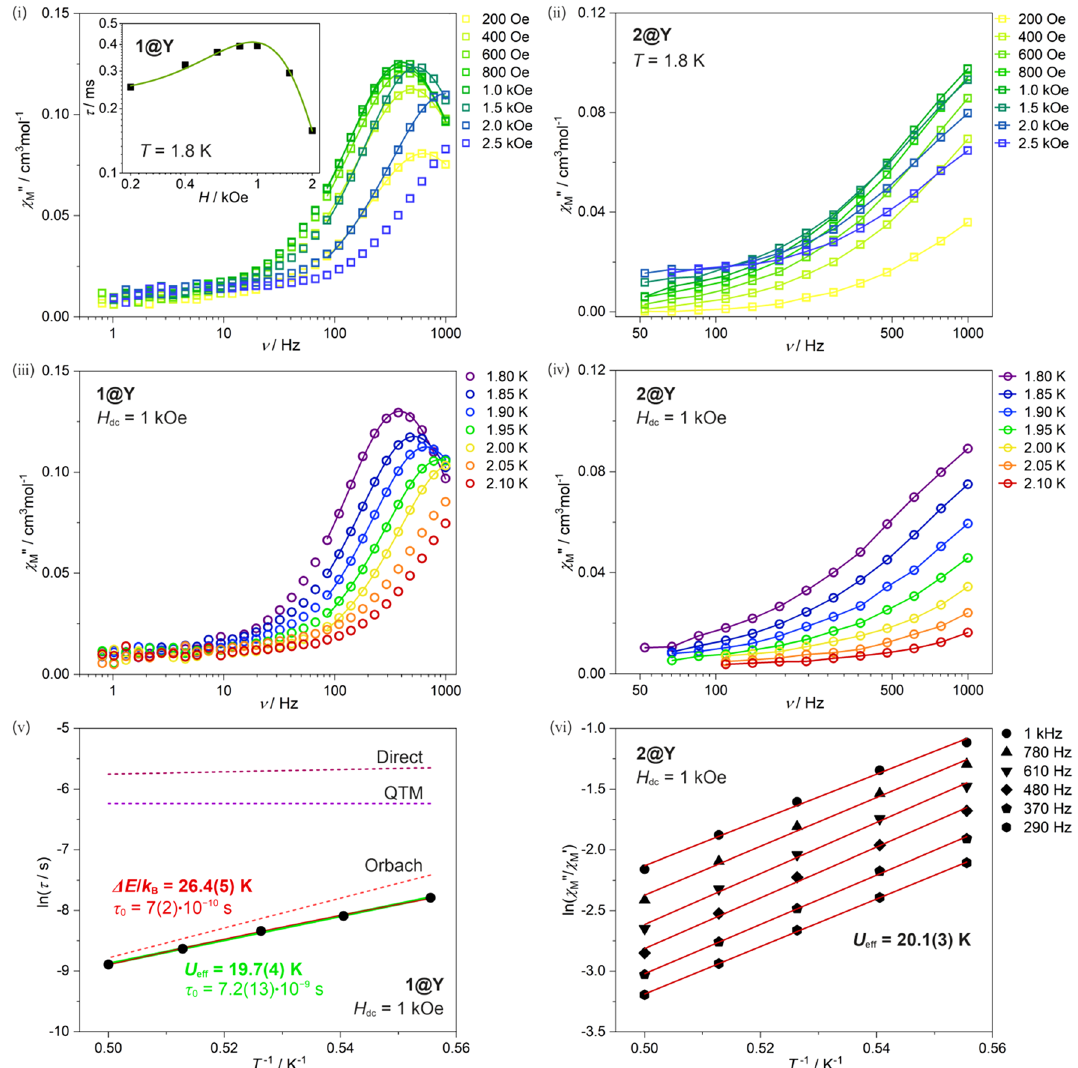
Figure 2. Dynamic ( ac ) magnetic properties of 1@Y (left) and 2@Y (right): dc -field-variable frequency dependences of the out-of-phase susceptibility, χ M ” of 1@Y (i) and 2@Y (ii) gathered in the 200–2500 Oe range at 1.8 K, and the related field dependence of the relaxation time for 1@Y (i), temperature-variable frequency dependences of the χ M ” of 1@Y (iii) and 2@Y (iv) collected in the 1.8–2.1 K range at H dc = 1 kOe, the related temperature dependence of the relaxation time for 1@Y (v), and the ln( χ M ”/ χ M ’) versus T –1 plots for the indicated frequencies of ac field (v). The empty colored points in the frequency dependences of the χ M ” (i–iv) represent the experimental data. The solid lines in the respective curves of 1@Y (i and iii) show the fitting according to the generalized Debye model while the analogous lines for 2@Y (ii and iv) are only to guide the eye. The solid lines in the field- (i , green line) and temperature-dependences (v, dark red) of the relaxation time of 1@Y represent the best-fit curve of the combined contributions from QTM, direct, and Orbach relaxation routes, while the black points show the experimental data. The light green line in (v), together with the green- colored text, represents the best-fit curves according to the Arrhenius law (the first term in the Eq. 7). The contributions from each type of relaxation were depicted in (v) as dotted lines. In the ln( χ M ”/ χ M ’) versus T –1 plots of 2@Y (vi), the black points show the experimental data while the solid red lines are the best-fit curves for a simplified approach elucidating the Arrhenius-type relaxation with the depicted effective energy